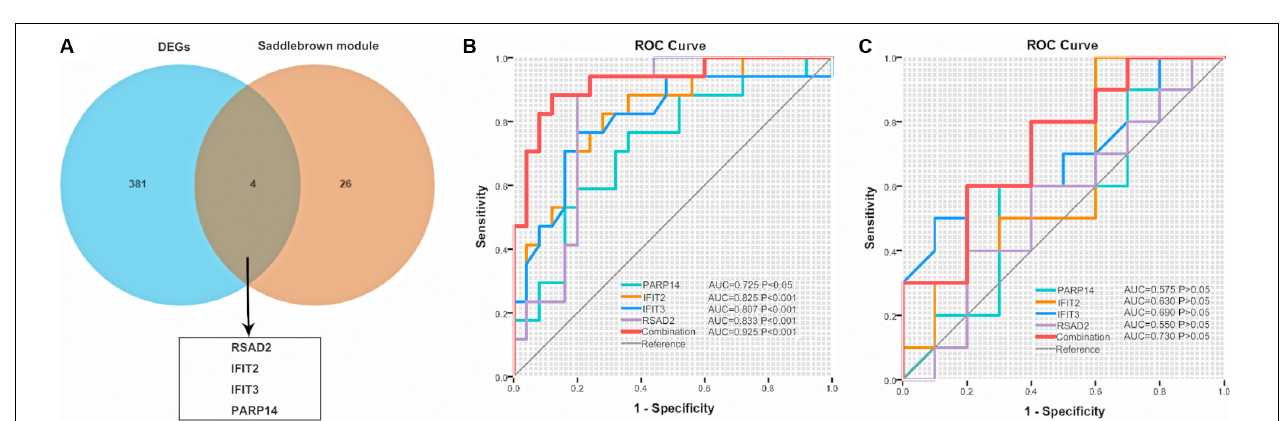
FIGURE 5 | Protein-protein interactions network. Visualization of the network connections among the most connected top 30 genes in the saddlebrown module (A) and purple module (B) .